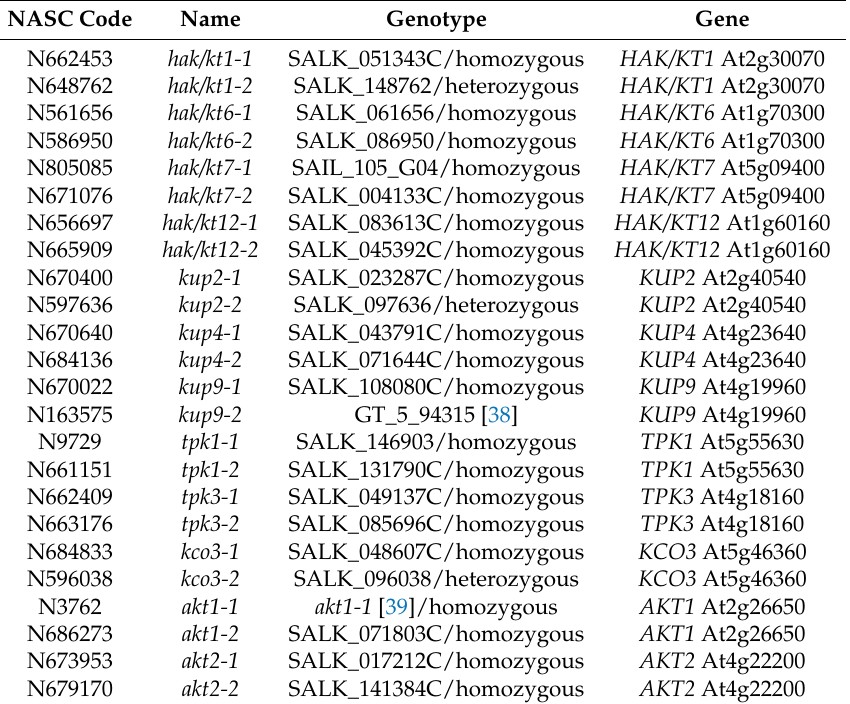
Table 1. Analyzed transfer DNA (T-DNA) insertion